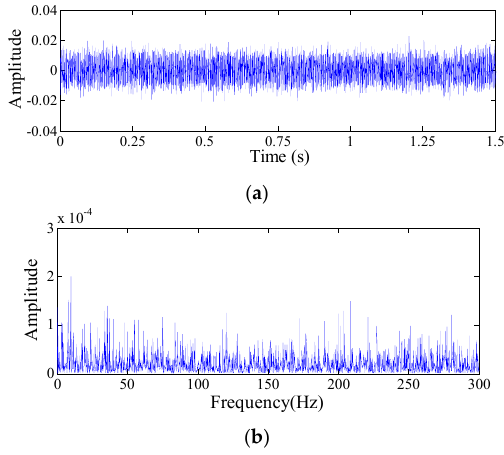
Figure 12. The analytic results of simulation signal with Gaussian white noise. ( a ) The time domain waveform for noisy simulation signal; ( b ) The envelope spectrum for noisy simulation signal.